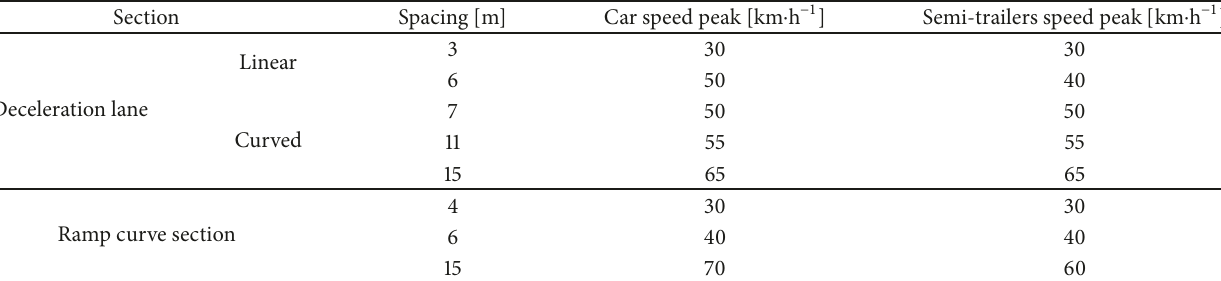
Table 7: The velocity of the vibration warning effect reaching peak values at different spacings.